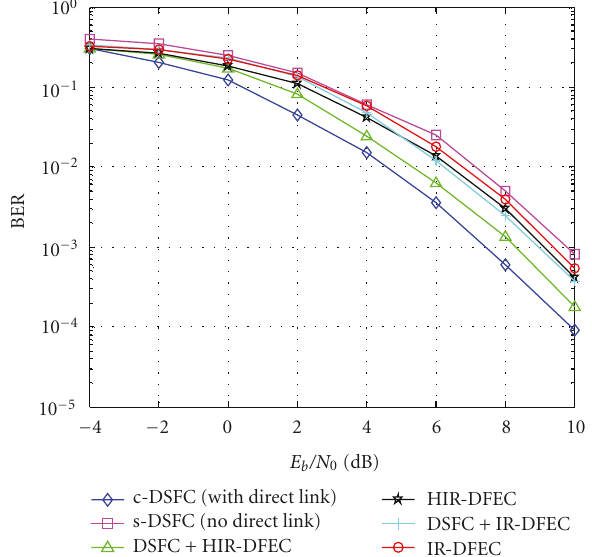
Figure 8: BER versus E b /N 0-directlink ; DSFC, DFEC, and DSFC+DFEC algorithms—scenario